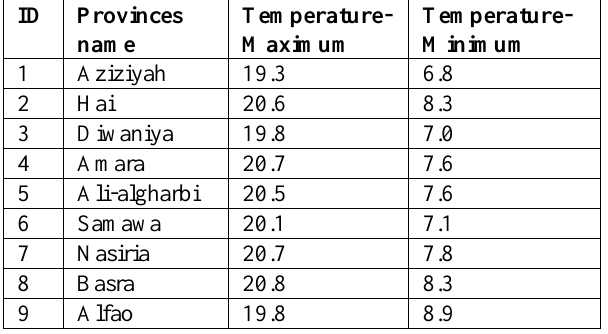
Fig.1: The location of climatological stations. Table1: The climate input data for nine climatological station at February